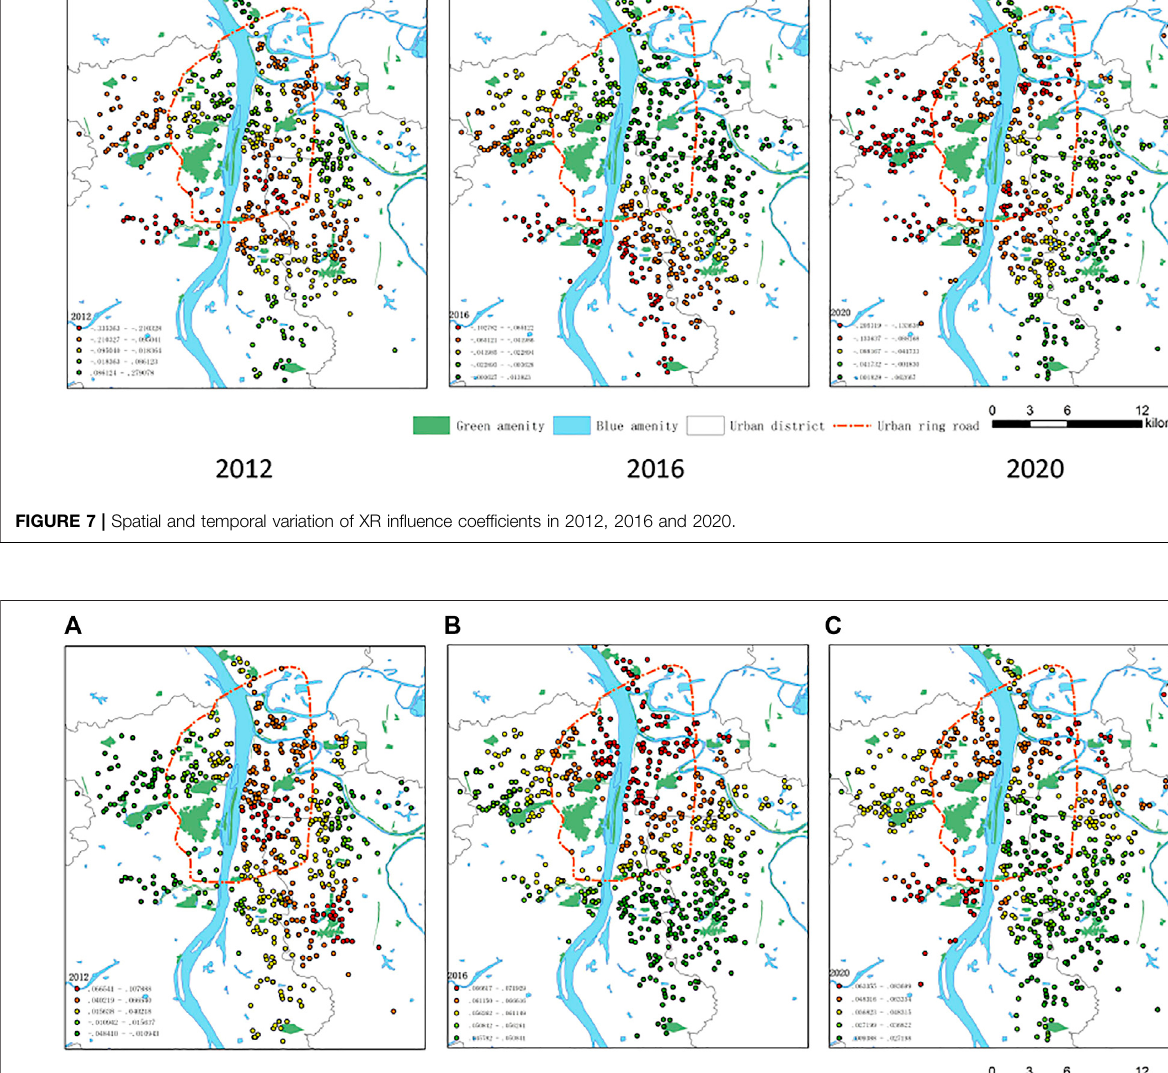
Frontiers in Environmental Science |